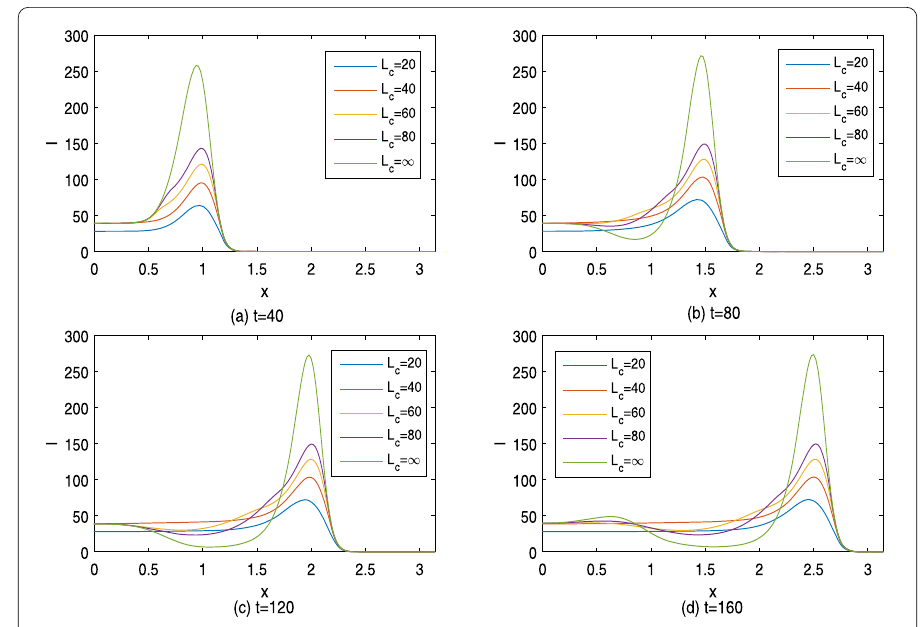
Figure 9 Traveling waves of I ( x , t ) for system (2.1) with respect to parameter I c . ( a ) t = 40; ( b ) t = 80; ( c ) t = 120; ( d ) t = 160